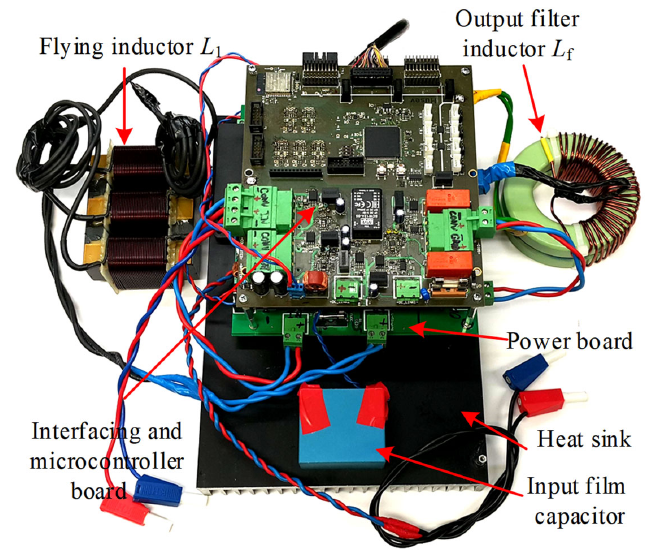
Figure 8. Control and power boards of the selected topology’s laboratory prototype.